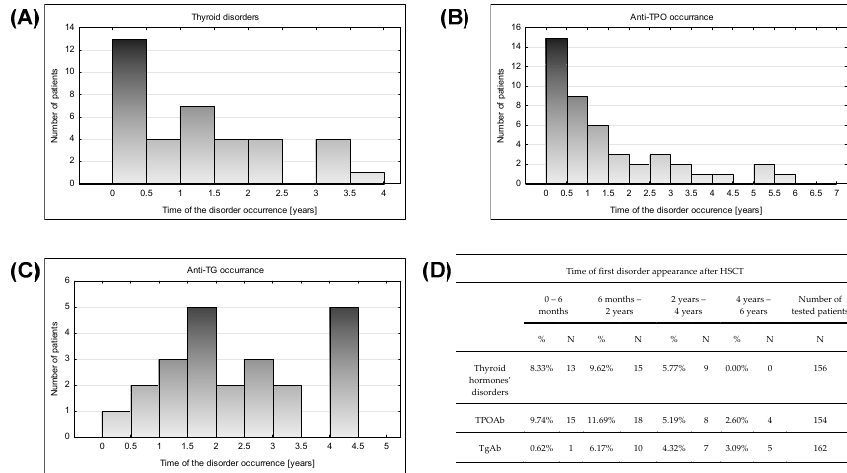
Figure 6. Time distribution of the thyroid disorders at time point 2 (disorder first appearance after HSCT) occurrence among patients; x-axis is the time after HSCT at which the disorder occurred [years] and the y-axis is the number of children that developed the disease; ( A ) Thyroid disorders—Shapiro-Wilk p = 0.00299, average 1.241, SD 1.06, variance 1.123, population 37, median 1.011; ( B ) Anti-TPO antibodies occurrence after HSCT—Shapiro Wilk p = 0.00001, average 1454, SD 1514, variance 2292, population 45, median 0.981; ( C ) Anti-TG antibodies occurrence after HSCT—Shapiro Wilk p = 0.317, average 2.371, SD 1.219, variance 1486, population 23, median 2217; ( D ) Table with the data used for the analysis.